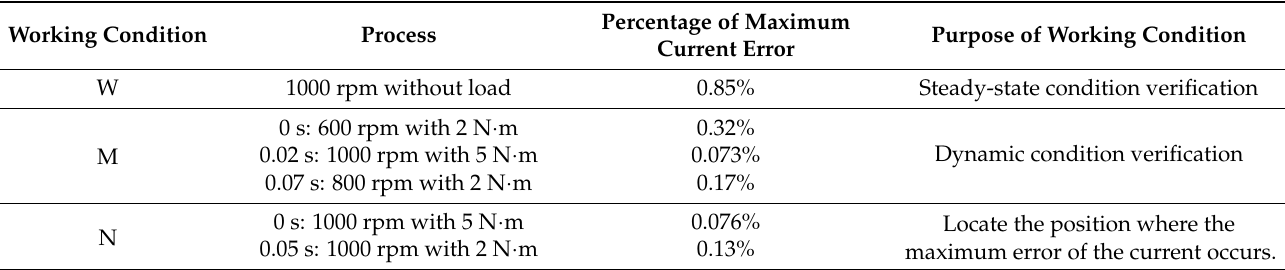
Table 3. Brief Comparison of Reconstructed Current Error.